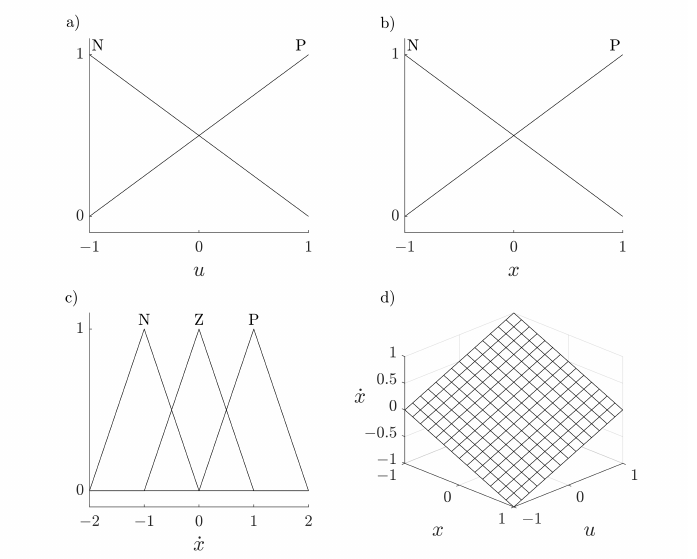
Figure 3. Fuzzy sets; ( a ) input set u , ( b ) input set x , ( c ) output set ˙ x centre of gravity and ( d ) output surface between ˙ x , x and u